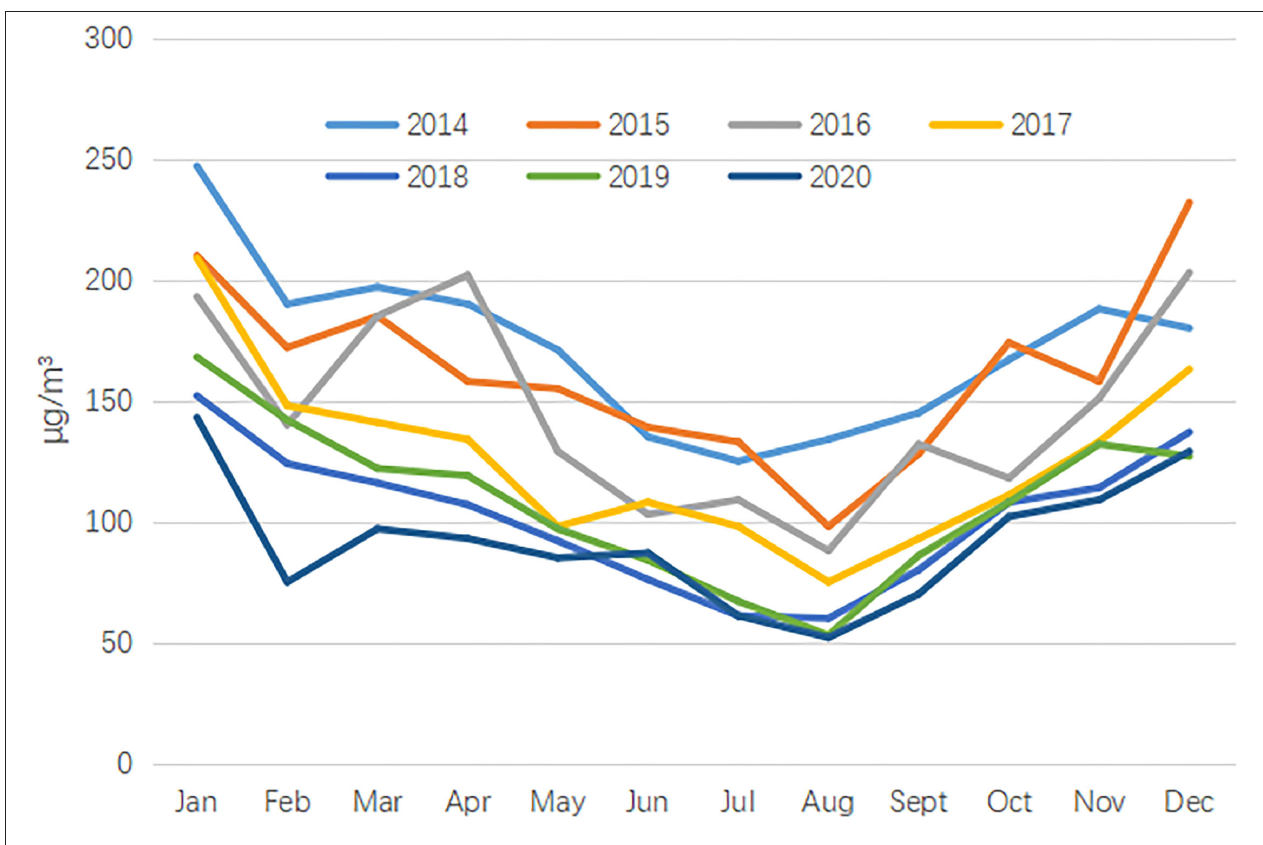
FIGURE 4 | The number of PM10 in different months from 2014 to